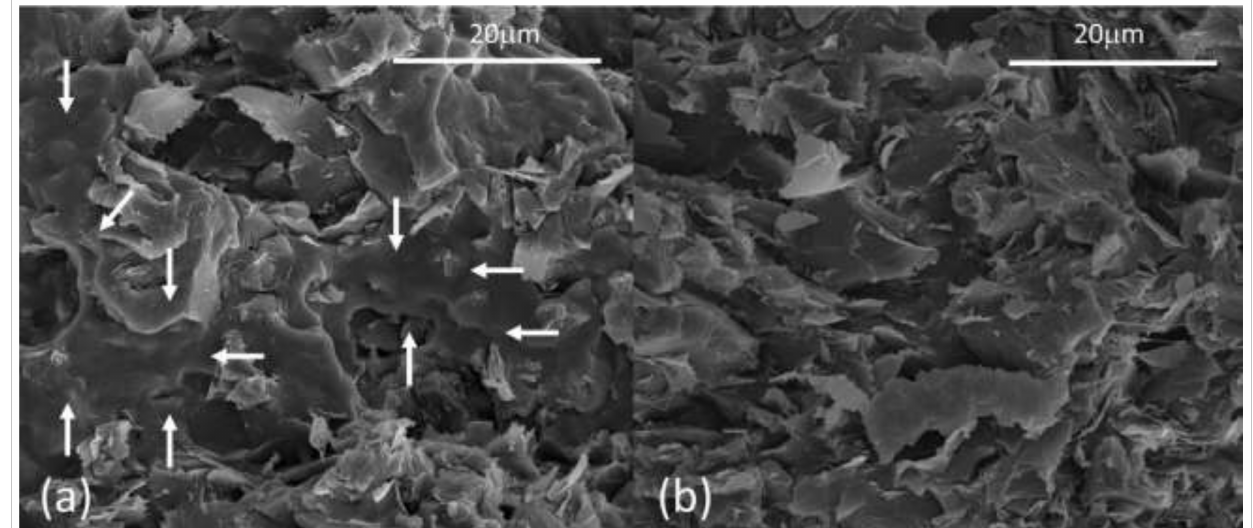
Figure 3. SEM images of the fractured samples of ( a ) PHA and ( b ) PLA films with 15 wt.% of GNPs.